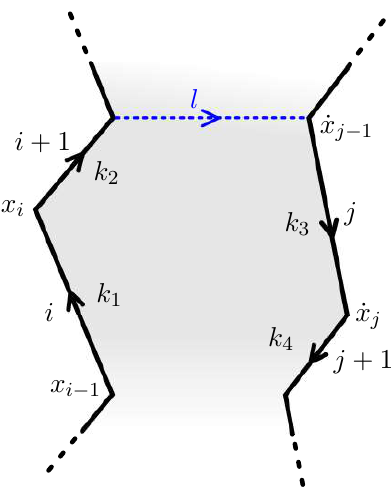
Figure 2 . The periodic Wilson lines con(cid:12)guration that is dual to the cylindrically cut double trace amplitude. Each line consists of the ordered gluon momenta in one of the two traces. Because the total momentum in each trace is non-zero, the dual line is not closed. Instead, it is repeated periodically and forms the boundary of the universal cover of the cylinder. The separation between the two Wilson lines is equal to the momentum that (cid:13)ows around the cylinder, l